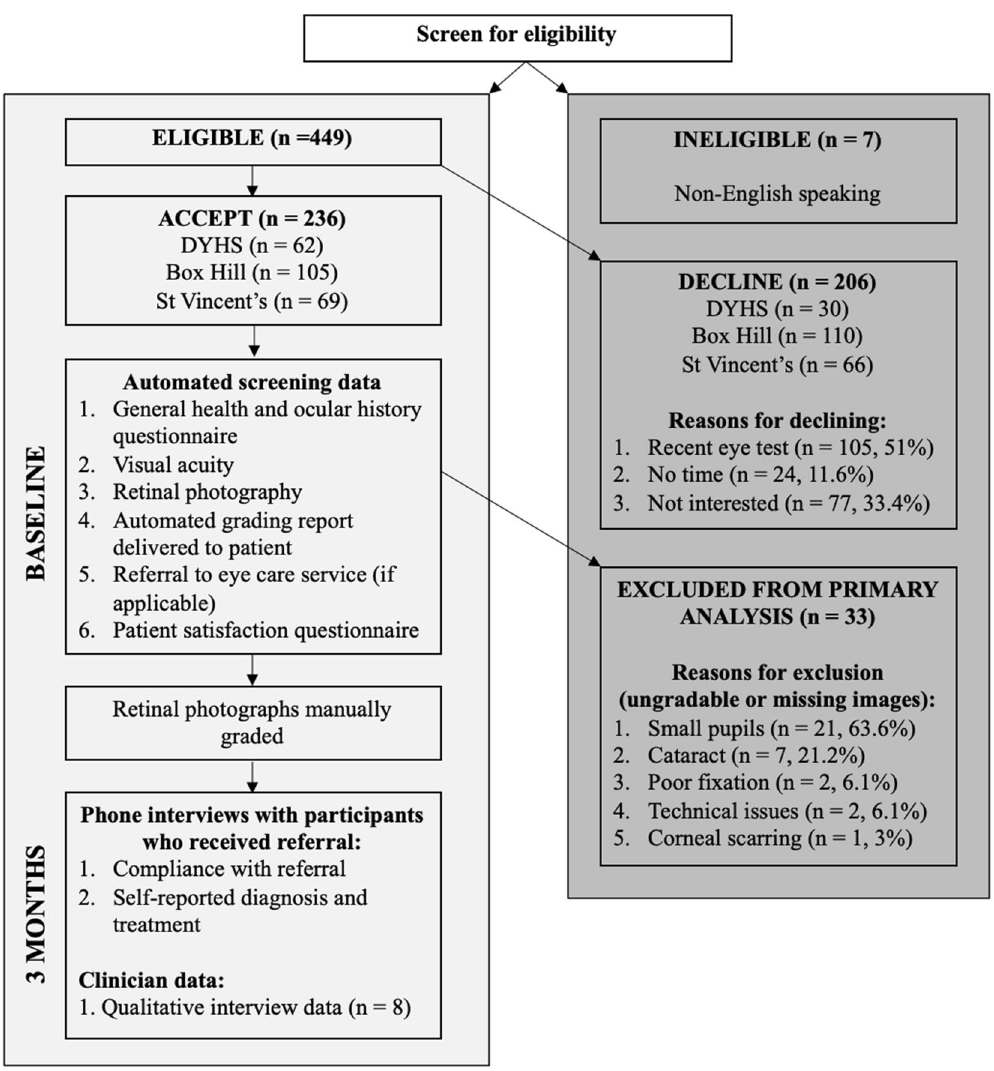
Figure 1. Flow chart of screening procedures and follow-up of participants and screening